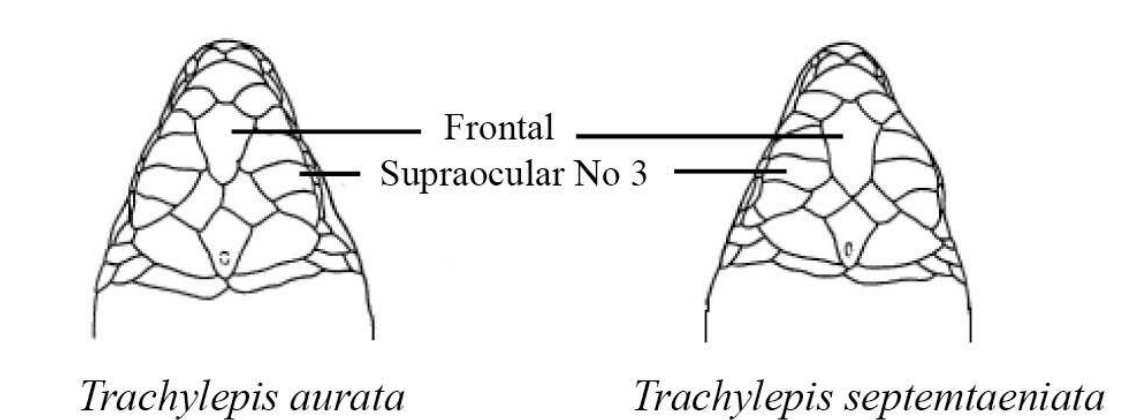
F IGURE 2. Pileus pholidosis of Trachylepis aurata (Linneaus, 1758) and T. septemtaeniata (Reuss, 1834). The third supraocular is separated from the frontal in aurata and in contact with the frontal shield in septemtaeniata (see Moravec et al., 2006)(Durmuş et al.,